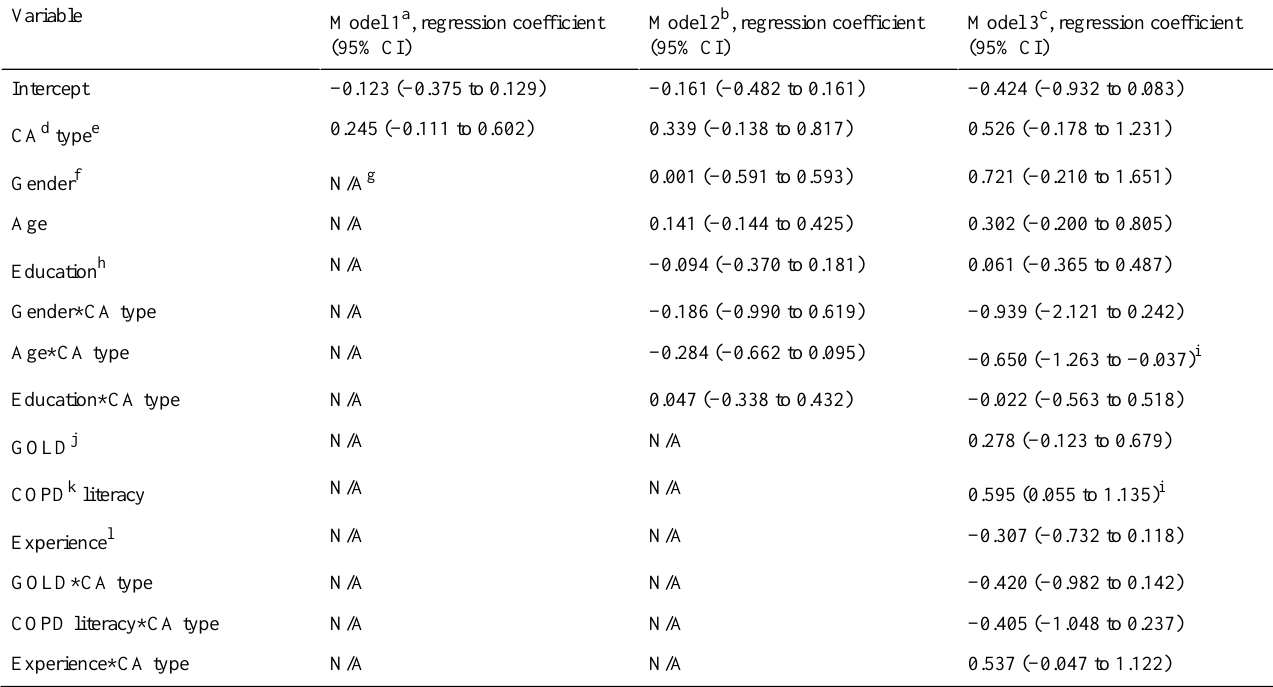
Table 10. Regression of conversational agent type, participants’ demographics, and chronic obstructive pulmonary disease–related characteristics in terms of participants’working alliance (attachment bond) with the conversational